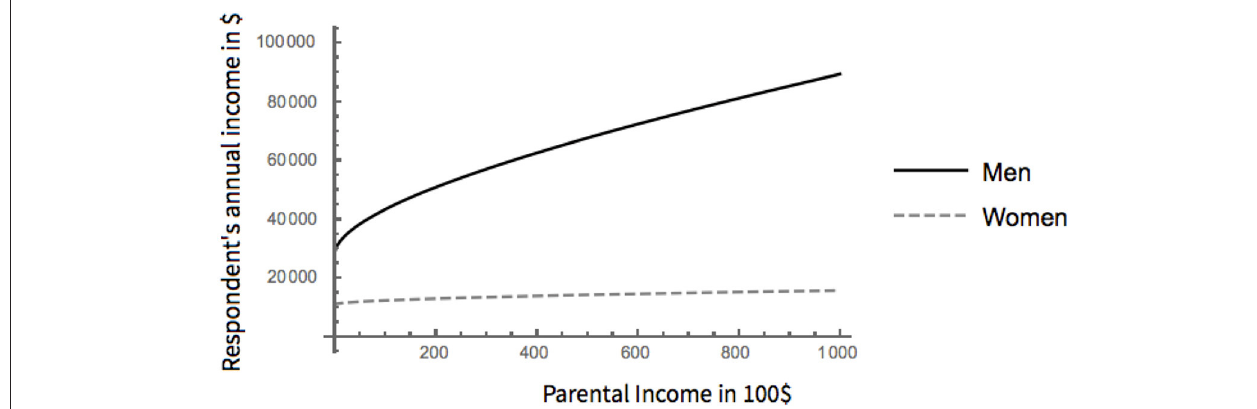
FIGURE 1 | Effect of parental income on respondent’s income for men and women.